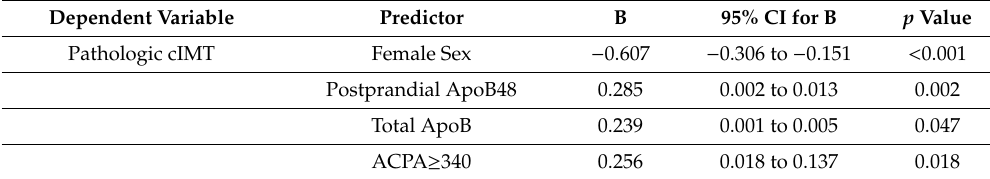
Table 6. Multiple linear regression of characteristics associated with cIMT in patients with